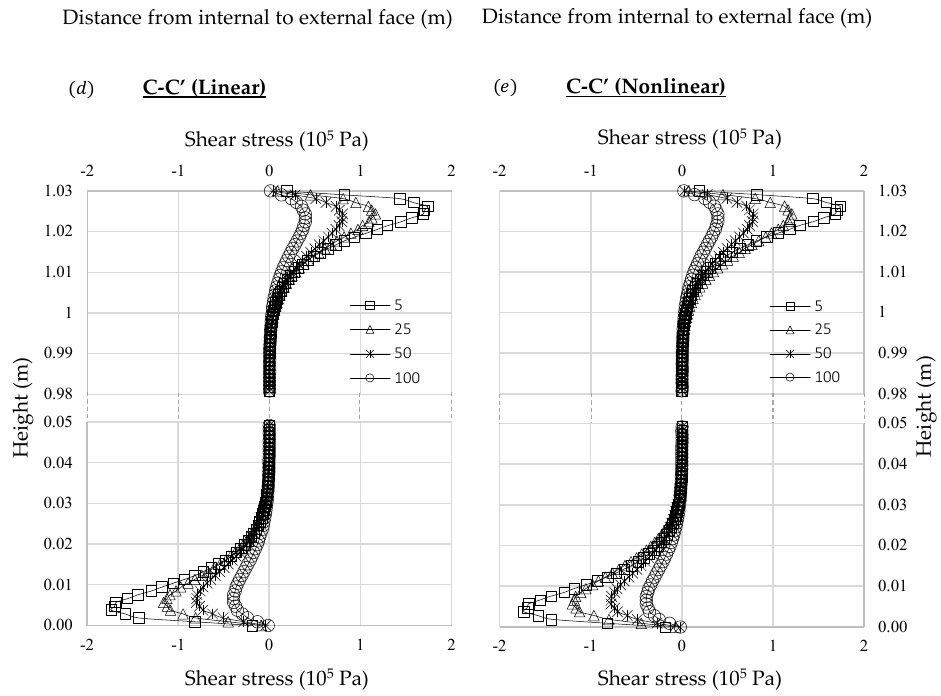
Figure 6. Comparison between linear and nonlinear numerical analysis of 2 σ xy : (a) Representation of a generic shear stress distribution, ( b , d ): linear analysis, ( c , e ): nonlinear